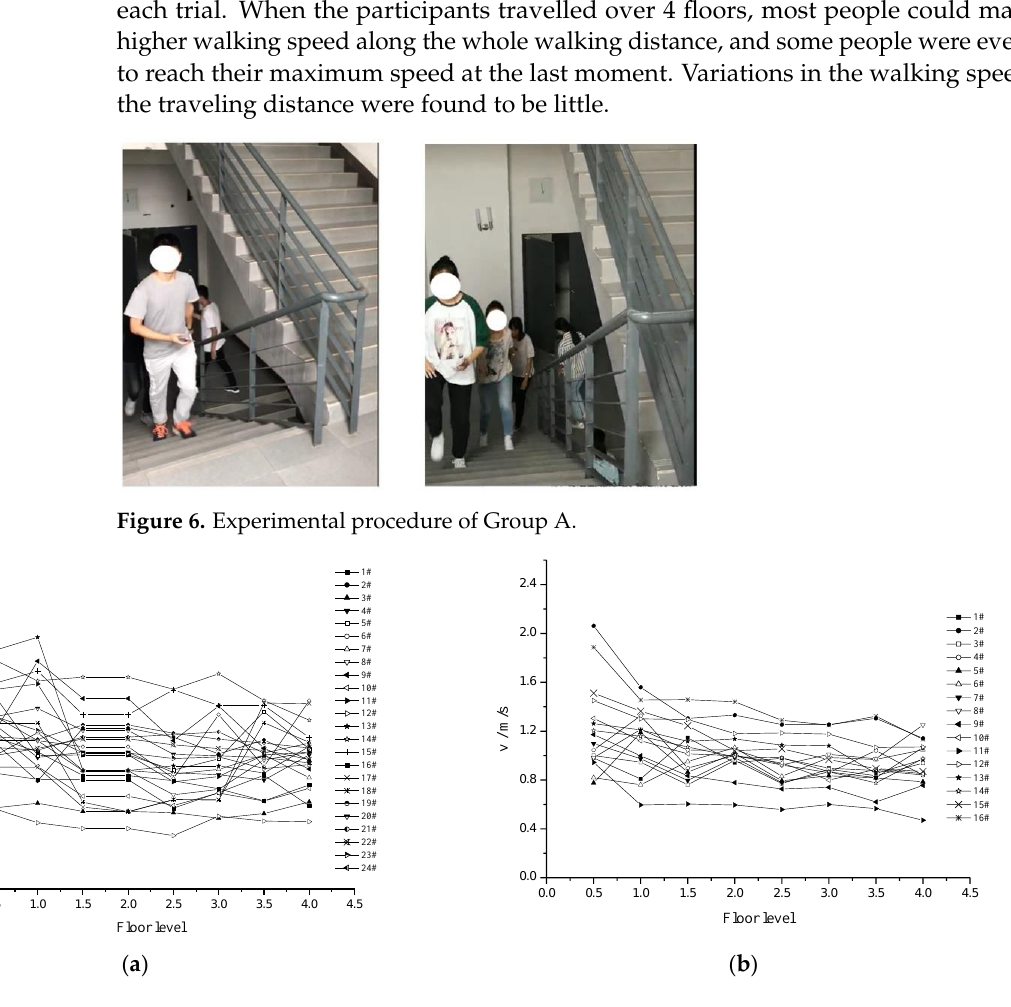
Figure 5. Definition of the ascending speed.